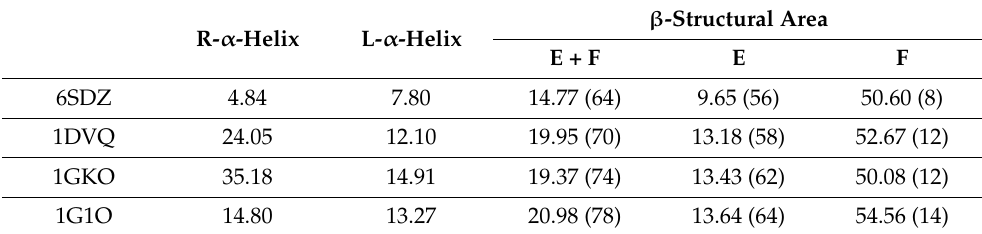
Table 2. Summary of the mean distances for the above-mentioned forms of the secondary structure in the analyzed proteins. The average distance for the R- (right-handed) and L- (left-handed) α -helix is calculated in relation to the averaged position of the Phi and Psi angles in a given structure. The average distance for the β -structural area is relative to the line Psi = − Phi. β -Structural R- α -Helix L- α -Helix